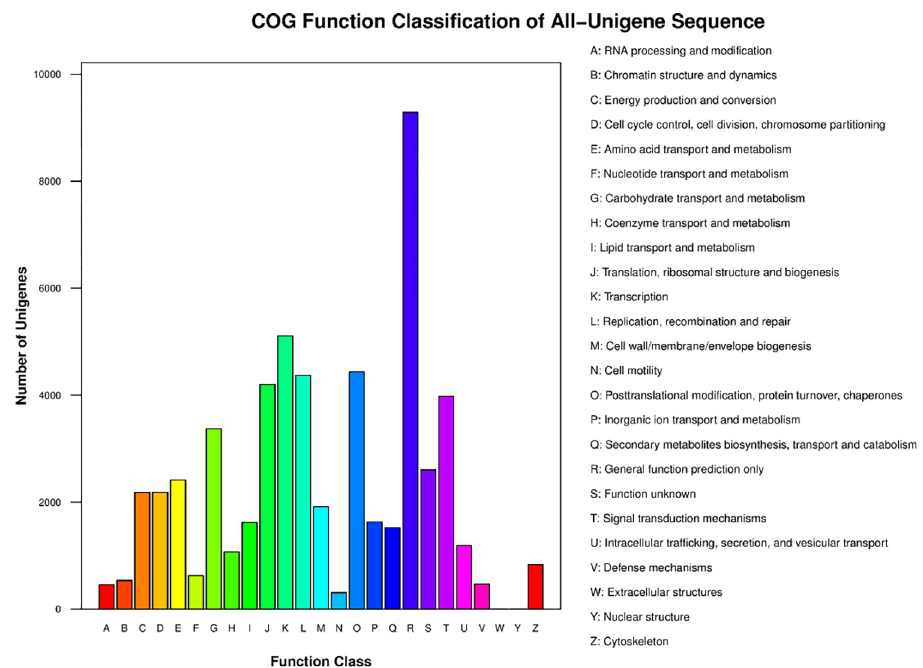
Fig 6. COG function classifications of unigenes for Clari as macrocephalus. Left-axis indicates the number of unigenes; letters on the x-axis represent different COG categories.